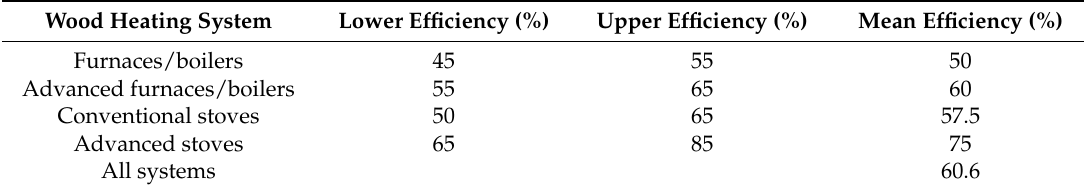
Table 3. Efficiency of different common types of residential heating systems that use wood logs as a feedstock [63,69]. Advanced furnaces/boilers and advanced stoves refers to appliances certified as low-emissions by the EPA or according to the CSA B415.1 standards. Lower Efficiency (%) Upper Efficiency